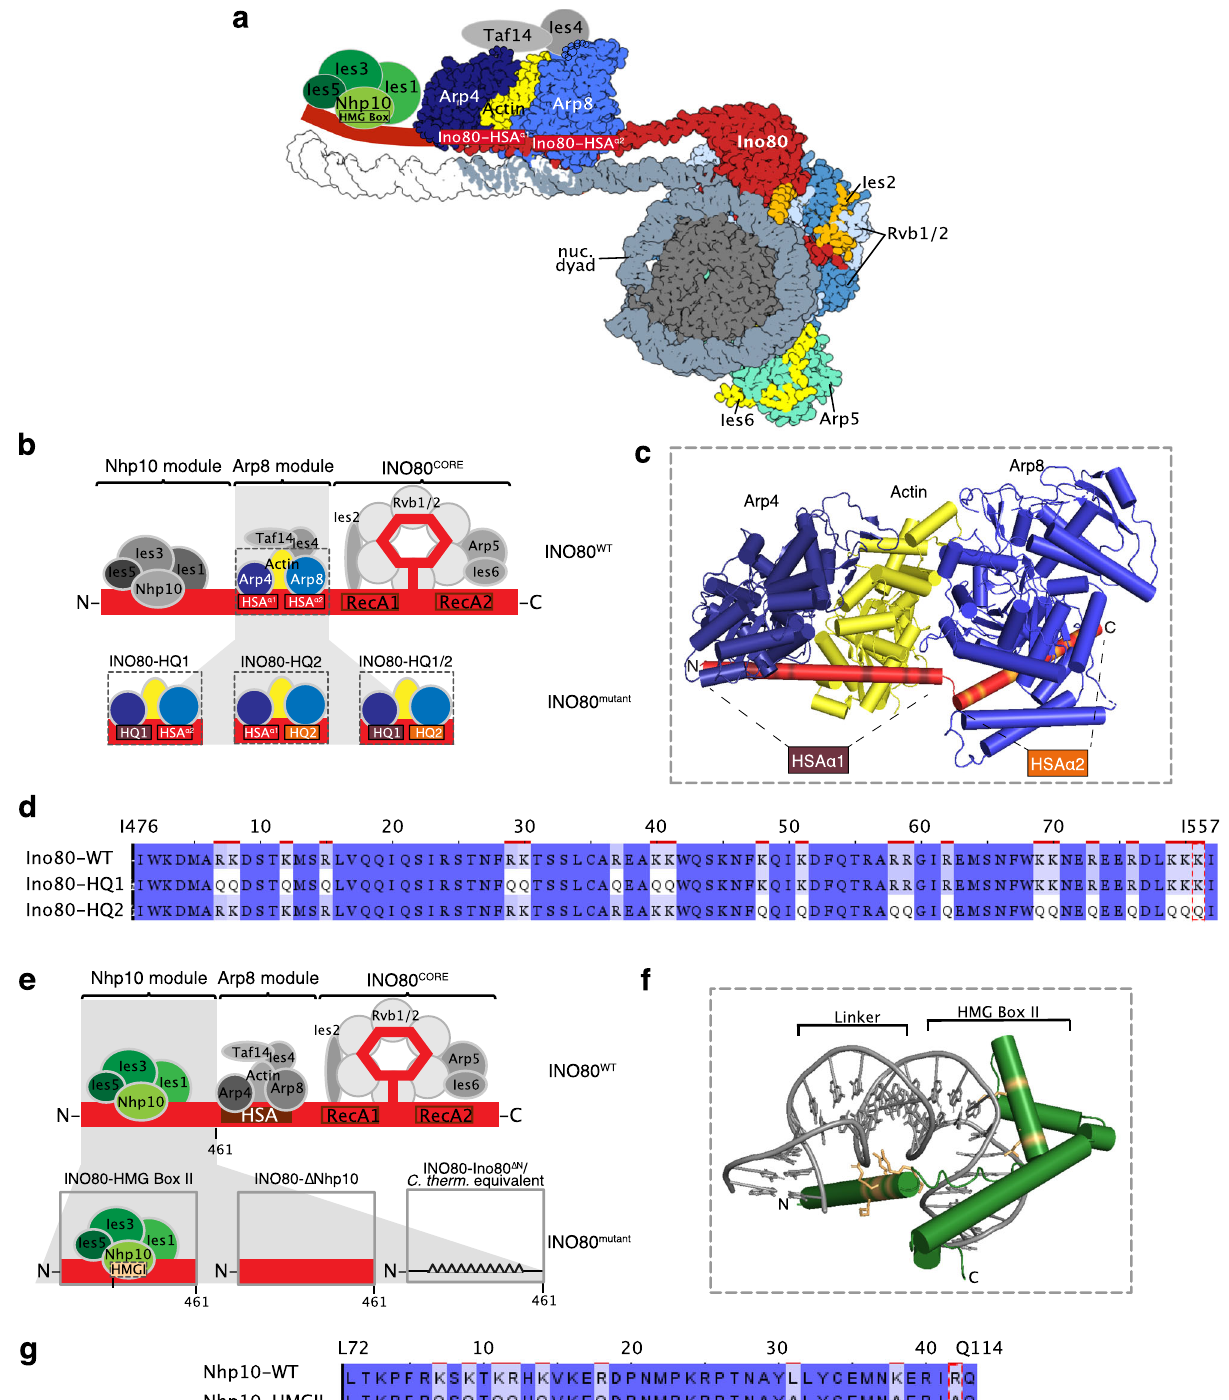
Fig. 4 Construction of INO80 mutant complexes. a Structure-based 40,54 model of a nucleosome bound by the INO80 complex with indicated subunits. Nhp10 module, Taf14, and Ies4 organization is assumed. b Schematic of INO80 complex submodule and subunit organization (top). Zoom into Arp8 module showing three mutant versions (bottom). c Cylindrical representation of the Arp8 module structure showing mutated residues of Ino80-HSA domain (highlighted in brown and orange). d Sequence alignment showing mutated residues in Ino80-HQ1 and -HQ2 mutants. e Schematic of INO80 complex organization as in b (top) but zoom into Nhp10 module (bottom) showing three mutant versions. f Model of Nhp10 HMG box-like and Linker region (residues 62 – 172) based on TFAM structure (pdb 3tq6). g Sequence alignment showing mutated residues in Nhp10-HMGII mutant. Images of a , b , e – g are also shown in the accompanying paper 41 . Color code for subunits is consistent across